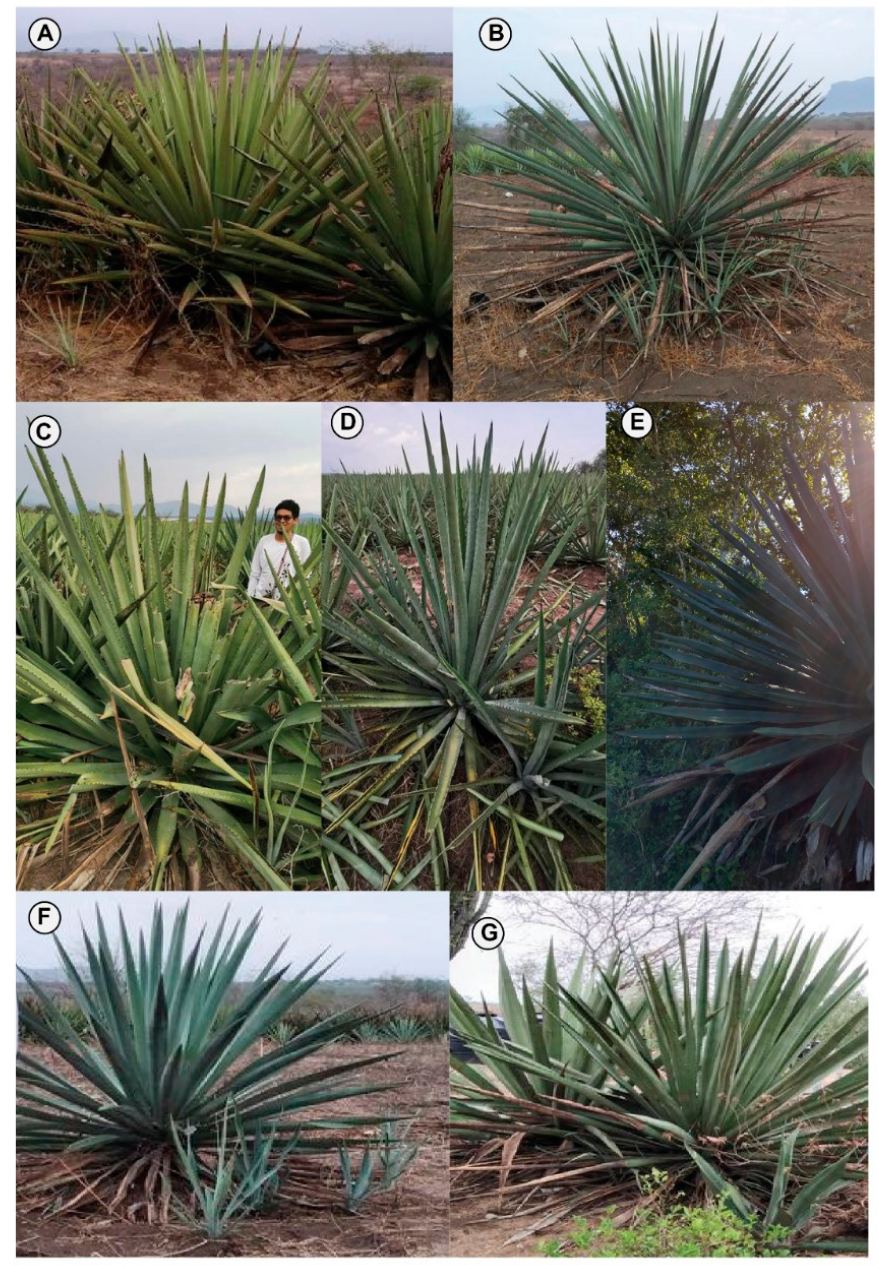
Figure 2. A. angustifolia landraces of Jalisco. ( A ) Ixtero Amarillo, ( B ) Ixtero Verde, ( C ) Lineño, ( D ) Barranqueño, ( E ) Cenizo, ( F ) Azul Telcruz, ( G )